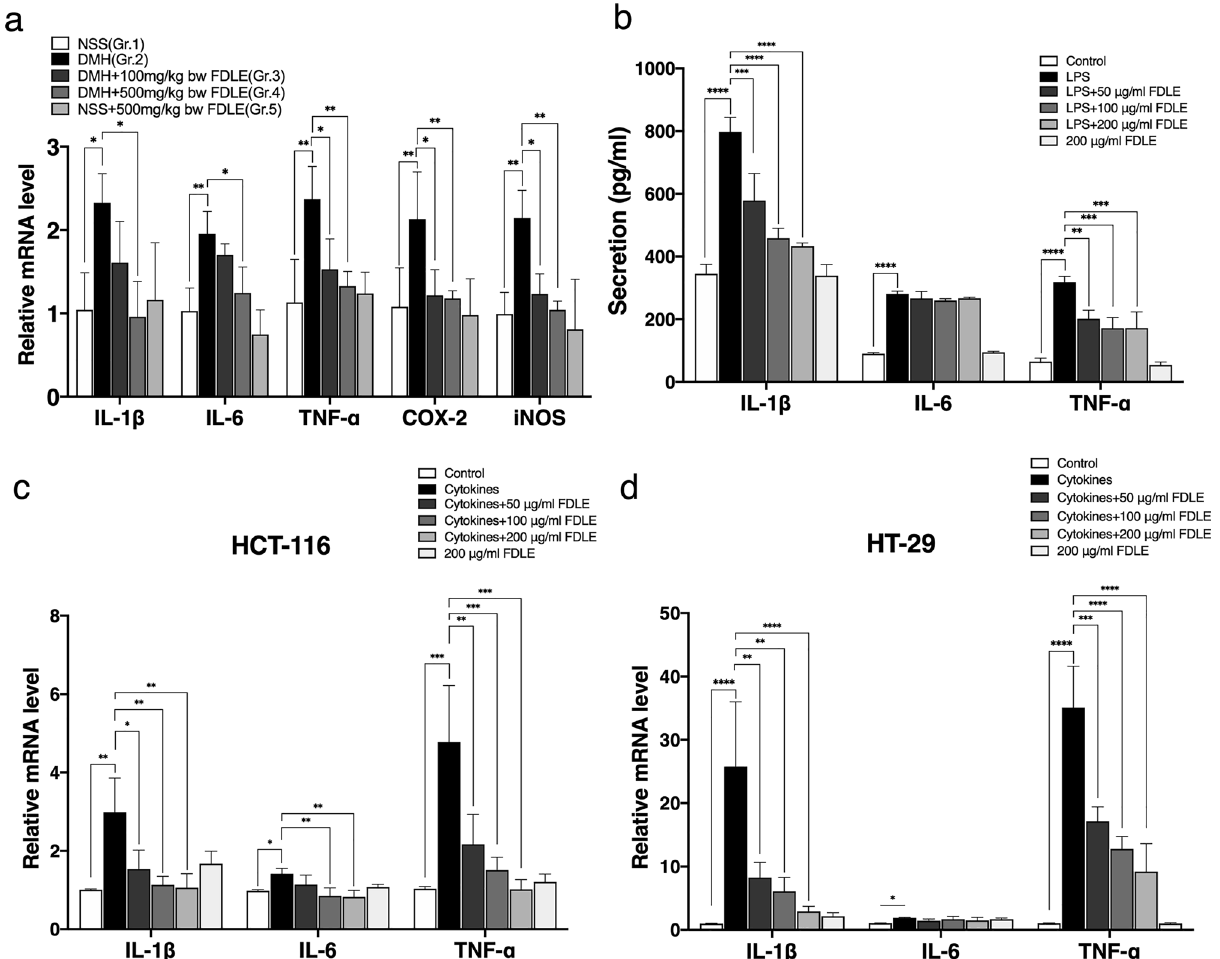
Figure 4. Anti-inflammation effects of FDLE ( a ) Relative mRNA level of pro-inflammatory cytokines and enzymes including IL-1β, IL-6, TNF-α, iNOS and COX-2 in rat colonic mucosa. Data are presented as the mean ± SD of 4 rats per group. ( b ) The secretion of pro-inflammatory cytokines including TNF-α, IL-1β and IL-6 in LPS induce RAW 264.7 cells treated with FDLE. Relative mRNA levels of pro-inflammatory cytokines, including TNF-α, IL-1β and IL-6 in cytokines (TNF-α, IFN-γ and LPS each 10 ng/mL) induced colorectal cancer cell lines at 48 h. ( c ) HT-29 cells. ( d ) HCT-116 cells. Data are presented as the mean ± SD of three independent experiments which are similar results. *p < 0.05, **p < 0.01, ***p < 0.001, ****p <